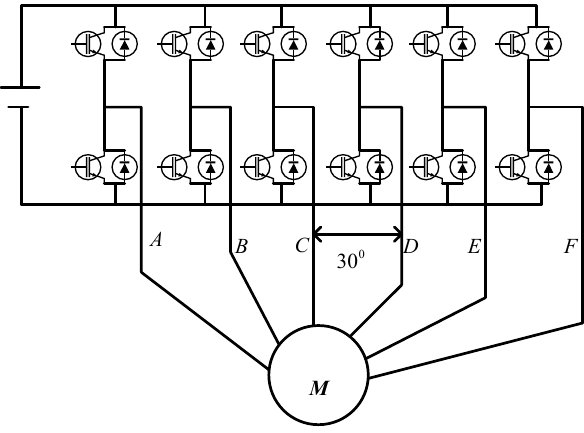
Figure 2. Drive system for an asymmetric six-phase permanent magnet synchronous motor (ASP_PMSM).